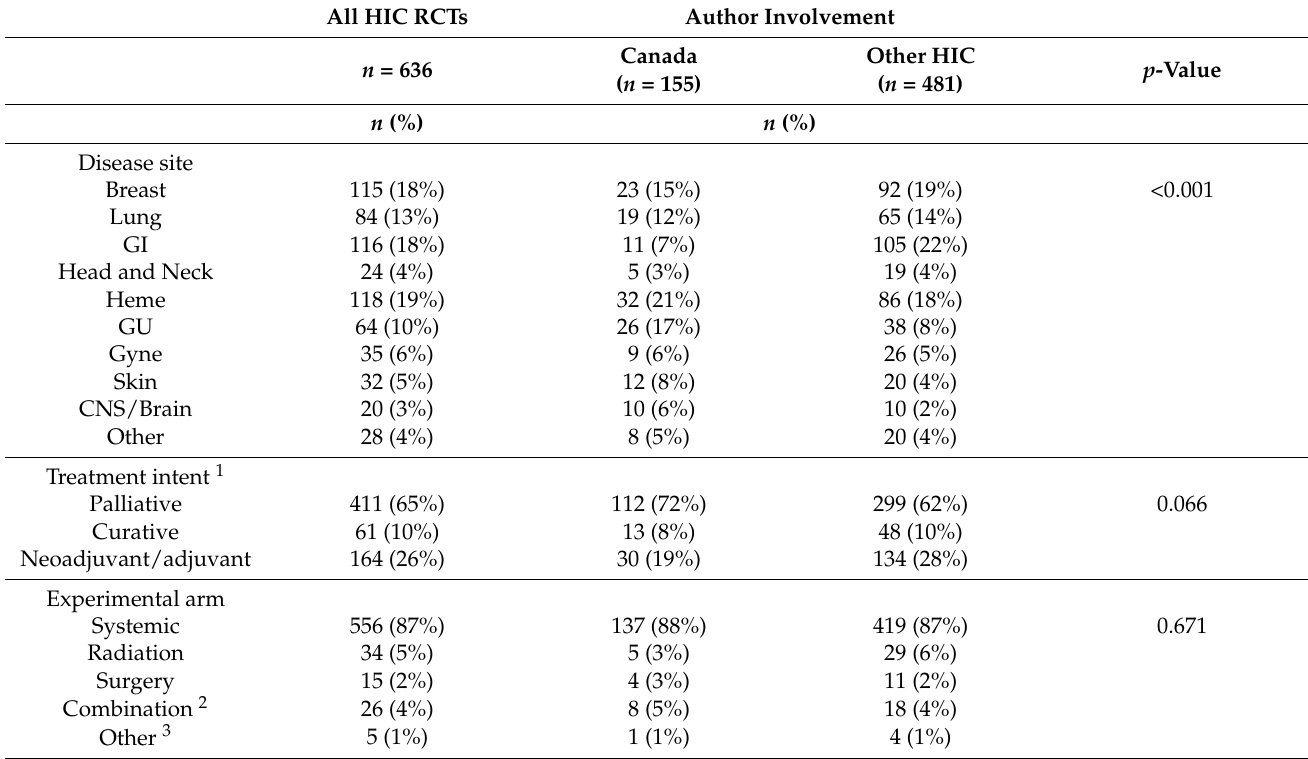
Table 1. Characteristics of all high-income oncology randomized controlled trials published globally 2014–2017. All HIC